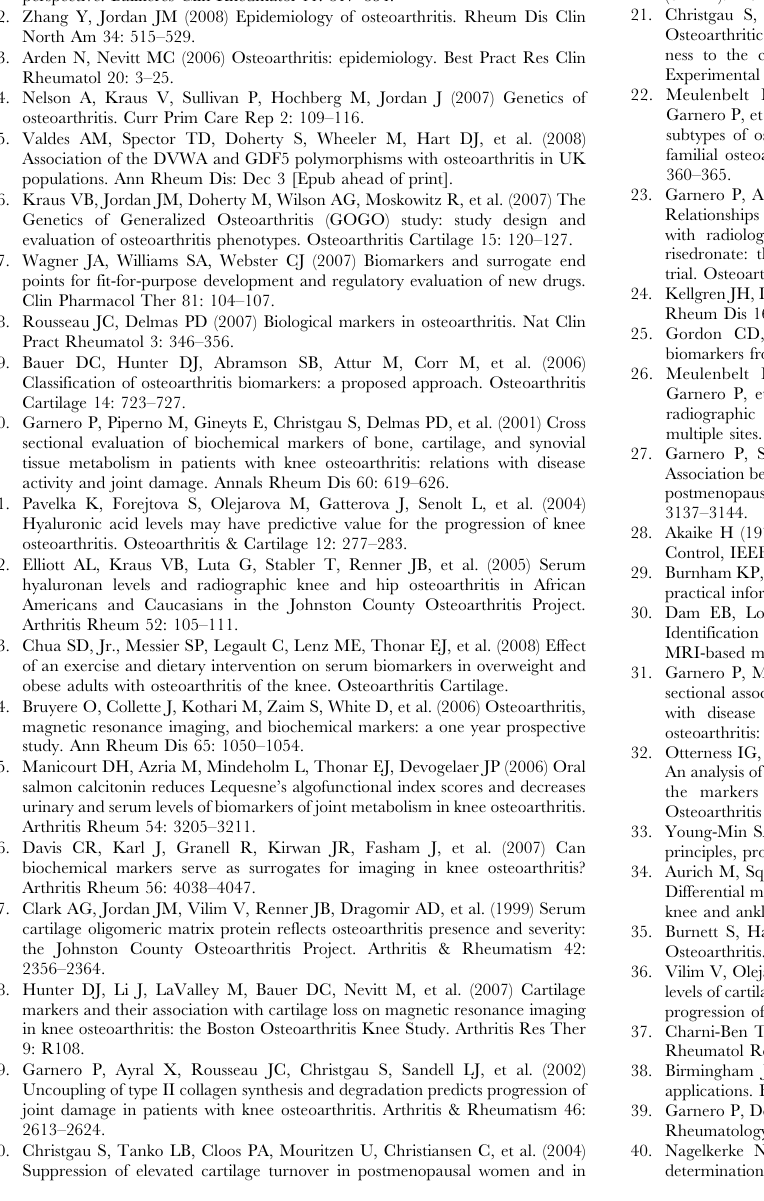
varied positively with JSN but negatively with OST. For